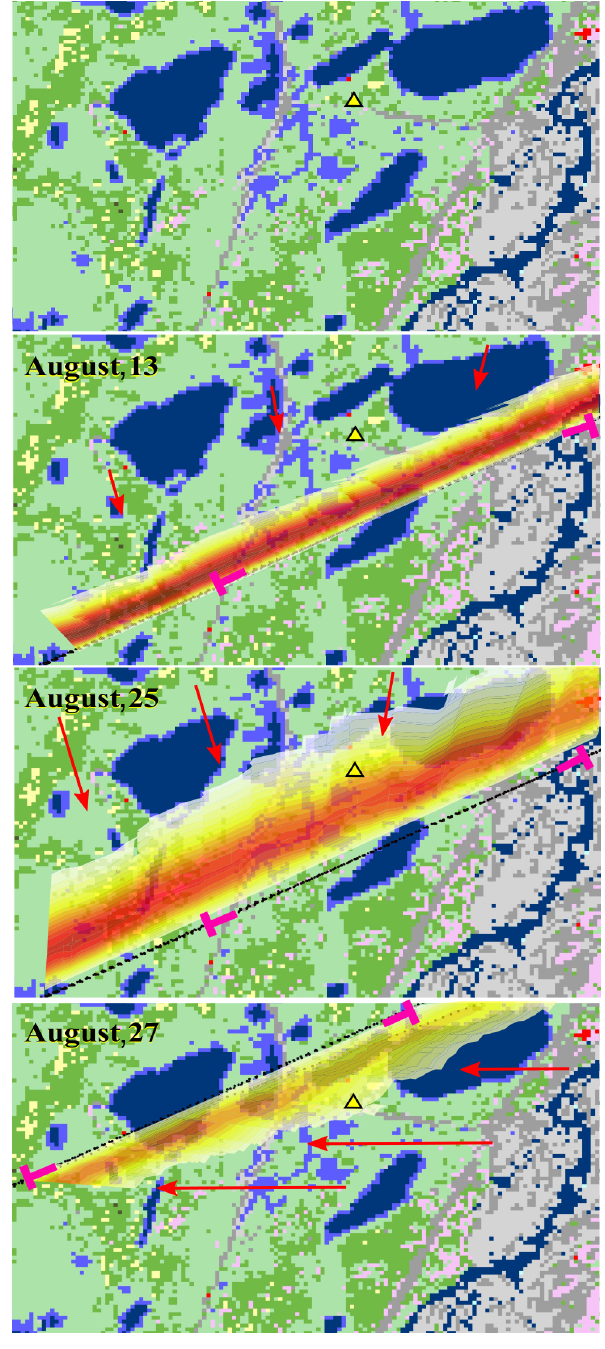
Figure 5. Flux footprints near the tower (yellow triangle) for the three tower flights (13.09:30, 25.18:00, and 27.19:00). They are laid over the NSSI-classified land-cover map (see Fig. 2). The top panel facilitates identifying the surface classes under each footprint. The flight track, always passing downwind of the tower, is shown as black points, each giving the starting position of a flux fragment. The darker and redder ribbon color represents greater probability of contribution to the total flux as described in the text. Red arrows indicate the mean direction of the wind. The part of the flight track used in the near-tower RFM calculation is located between the ma- genta